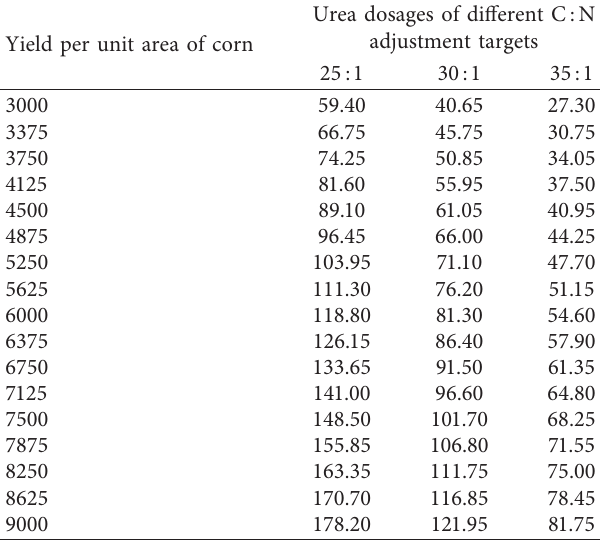
Table 10: Enquiry table for urea application quantity of corn straw returning to the field with different yields per unit area. Yield per unit area of